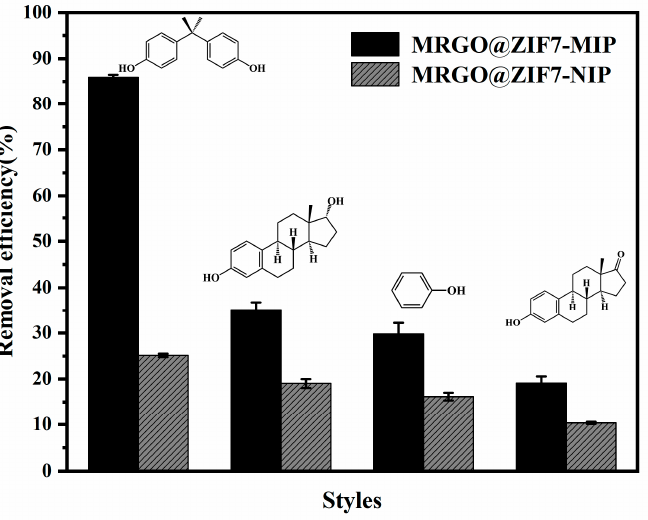
Figure 8. Removal efficiency of interfering molecules. Other conditions: 10 mg sorbent, 10 mL sam- ple solution, shaking time 1 h, temperature 25 °C.